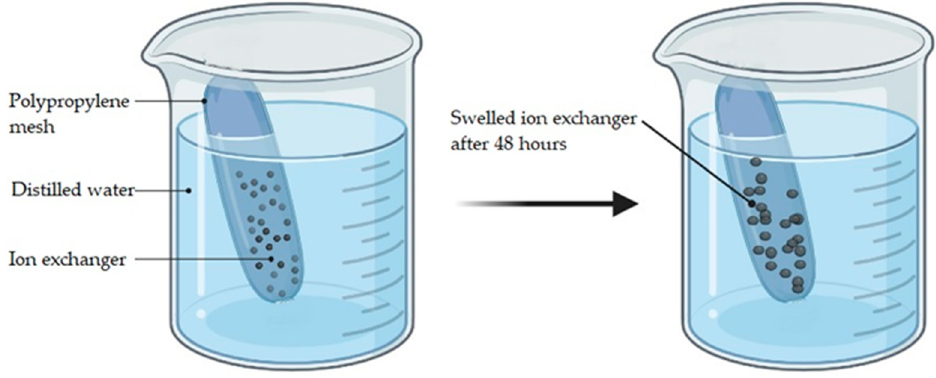
Figure 1. Representation of swelling process of ion exchangers for polymers swelling coefficient